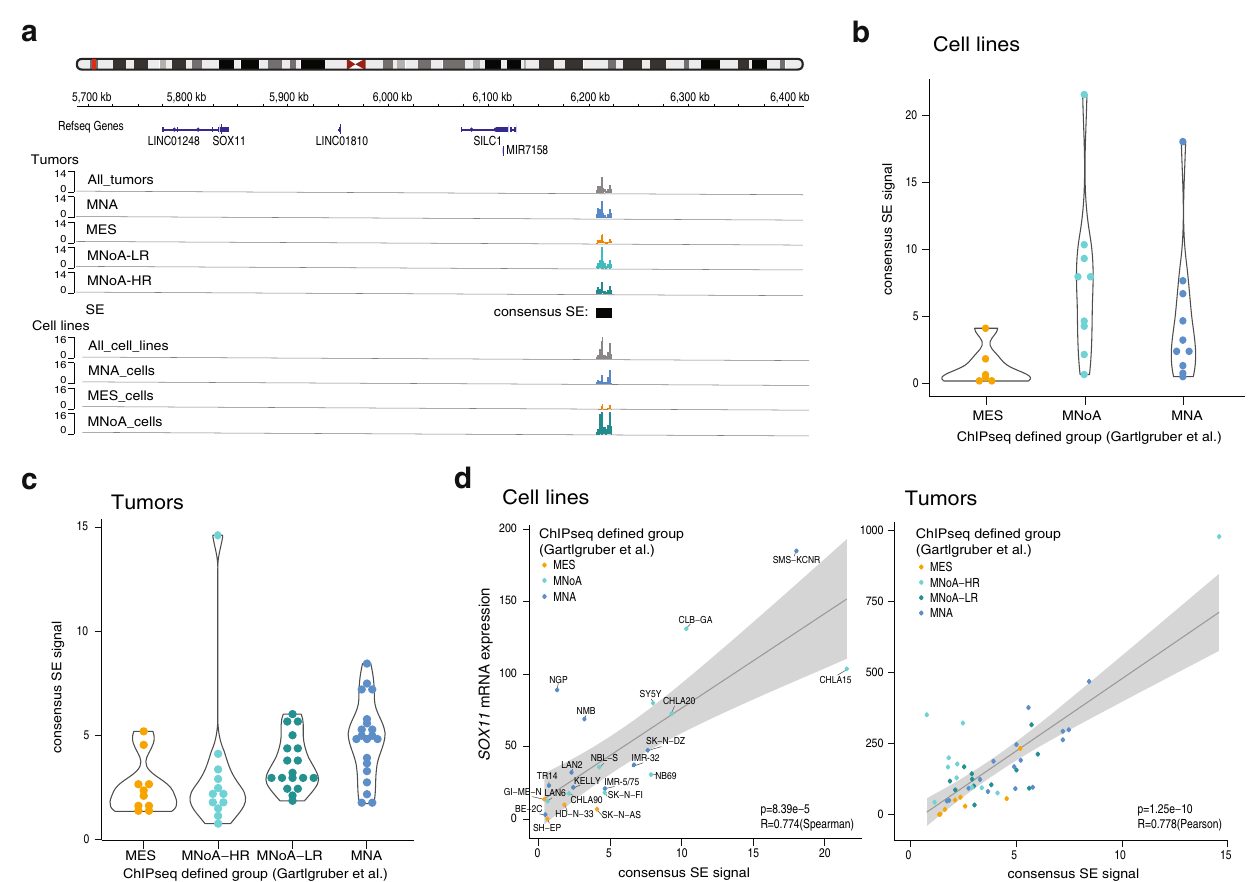
Fig. 2 | SOX11 is fl anked by multiple cis -interacting adrenergic speci fi c enhan- cers. a Super-enhancer calling (present in at least 2 samples and not overlapping withH3K4me35kbfromtranscriptionstartsite)downstreamof the SOX11 locusin NB tumors (MNA=adrenergic MYCN ampli fi ed, MES=mesenchymal,